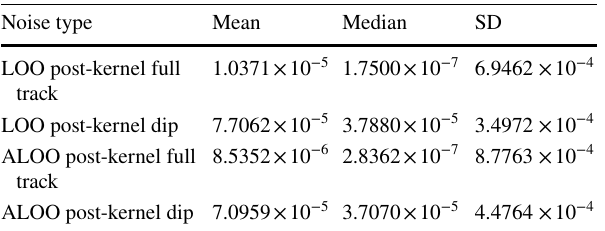
The statistics are calculated from the wheelset displacement differ- ences between the original simulations (the orange line in Figs. 18– 21) and the 200 simulations with normal noise and amplified noise, respectively. Furthermore, the statistics are based on the differences over the entire track or over the large dip seen in Fig. 21. Row one shows summary statistics of the wheelset displacement differences between the original simulation and the 200 simulations with normal noise (LOO estimated noise) over the entire track. The explanation for row two is the same as for row one, however, the statistics are only based on the differences over the large dip. Row three and four then correspond to row one and two, respectively, where the amplified noise (ALOO) has been used for the 200 simulations